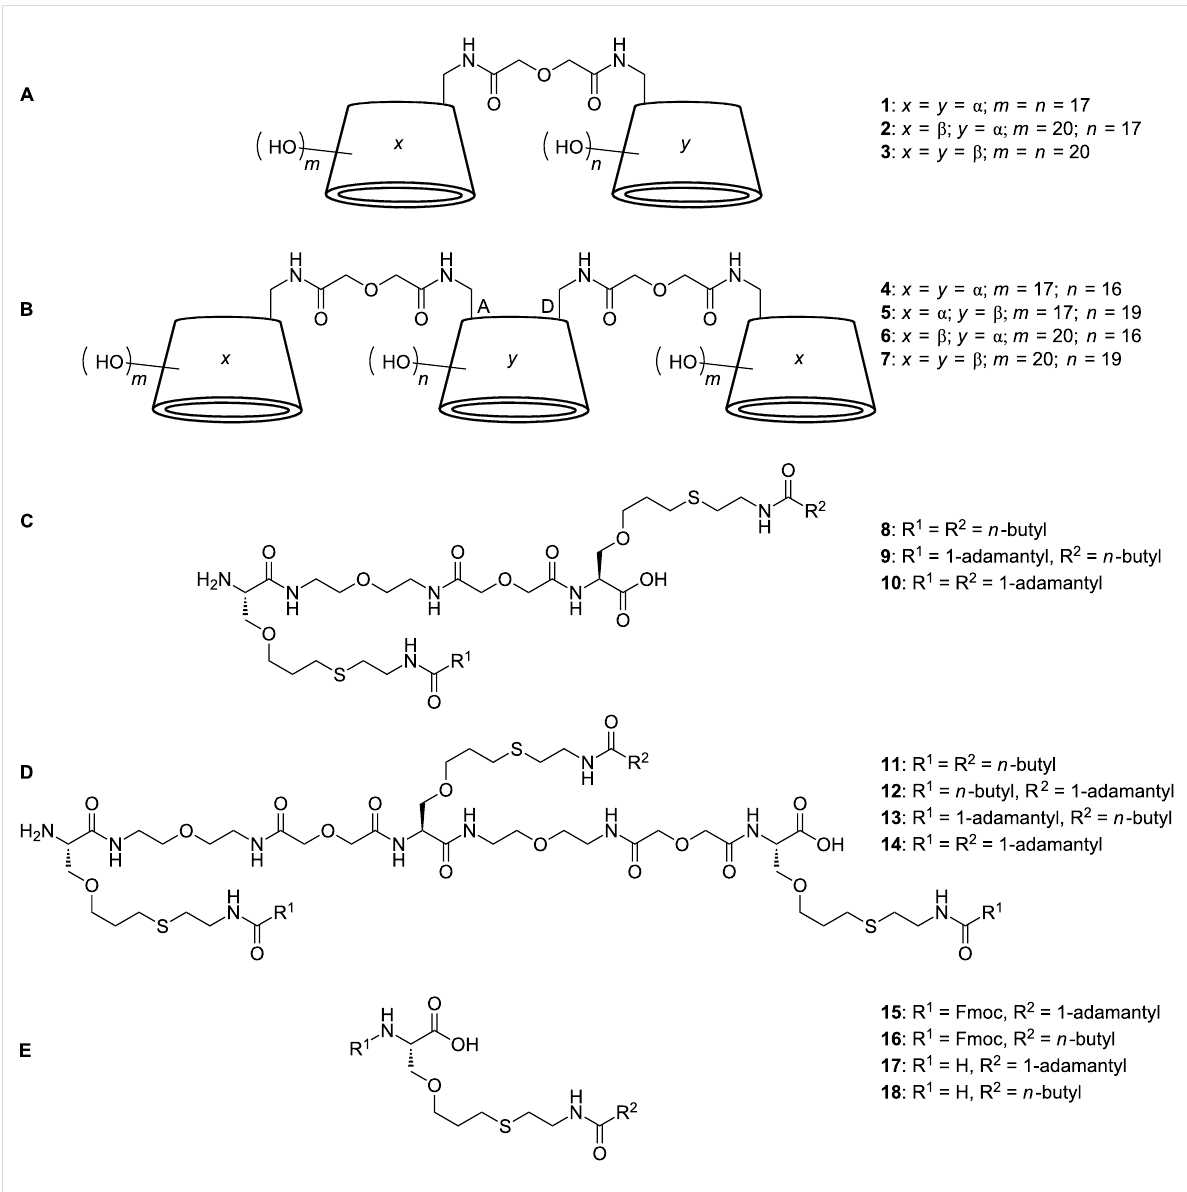
Figure 1: Chemical structures of the di- (A) and trivalent (B) CD sequences, the di- (C) and trivalent (D) guest sequences and the monomeric serine derivatives (E).